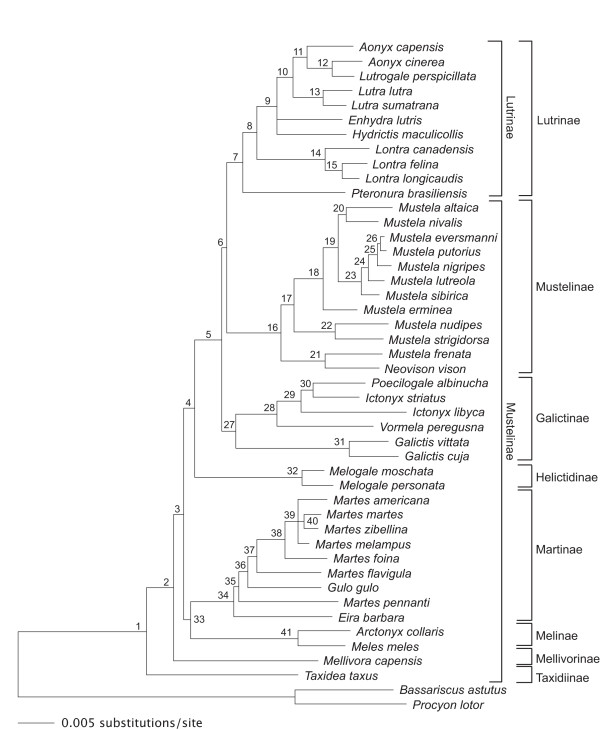
Bayesian consensus phylogram of 14,002 trees (burn-in of 6,000 trees) for the Mustelidae using the GTR + I + G model of DNA substitution. Nodes are numbered (1–41), with bootstrap (ML and MP) and posterior probabilities (BI) in Table 1. Brackets at right show subfamily classification as proposed by Wozencraft [7] (inside) and Fulton and Strobeck [11] and Sato et al [15] (outside). Branch lengths are proportional to number of substitutions per site (scale bar).